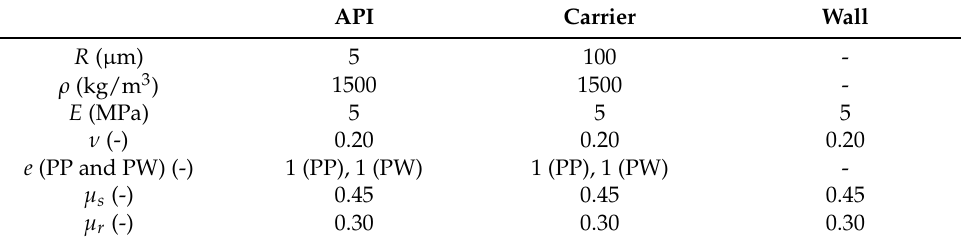
Figure 1. System with two particles and a wall used in the simulations. Table 1. Physical and mechanical properties used in the simulations (PP = particle–particle; PW =